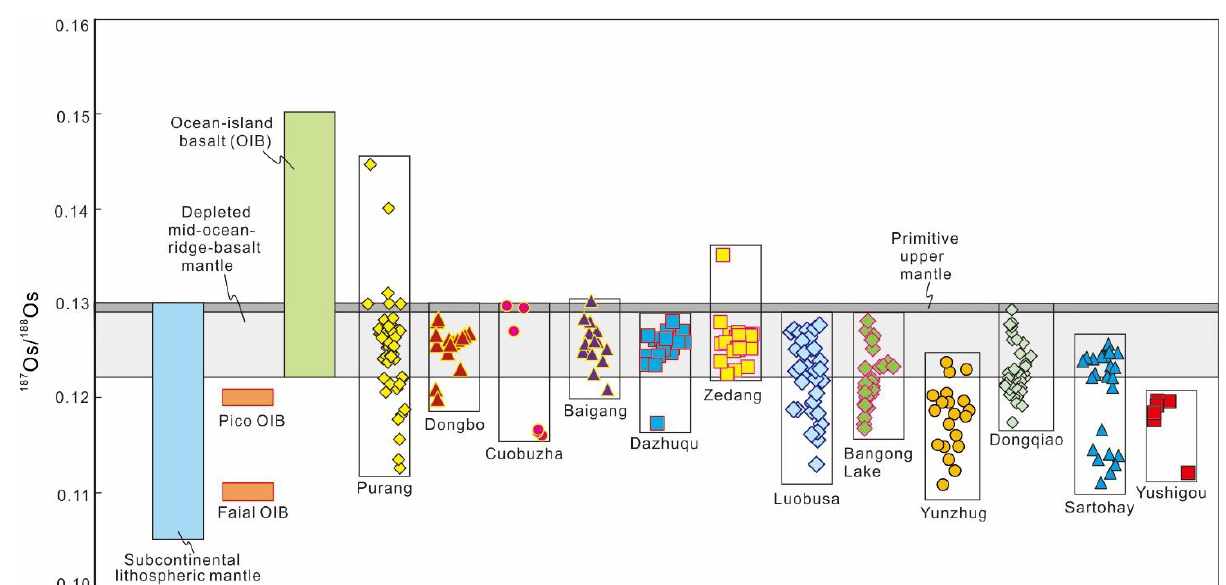
Figure 3. Osmium isotopic values of diamond-bearing chromitite and peridotite in different ophiolites. Osmium isotopic values of primitive upper mantle, depleted mid-ocean-ridge-basalt mantle, Ocean-island basalt (OIB), Pico and Faial OIB from the Azores after [71]. Osmium istotopic data references: Purang [63,74,75]; Dongbo [62]; Cuobuzha [65]; Baigang [63]; Dazhuqu [76]; Zedang [63,77]; Luobusa [72,78,79]; Bangong Lake [80]; Yunzhug [81]; Dongqiao [67,79,82]; Sartohay [79]; Yushigou [59].